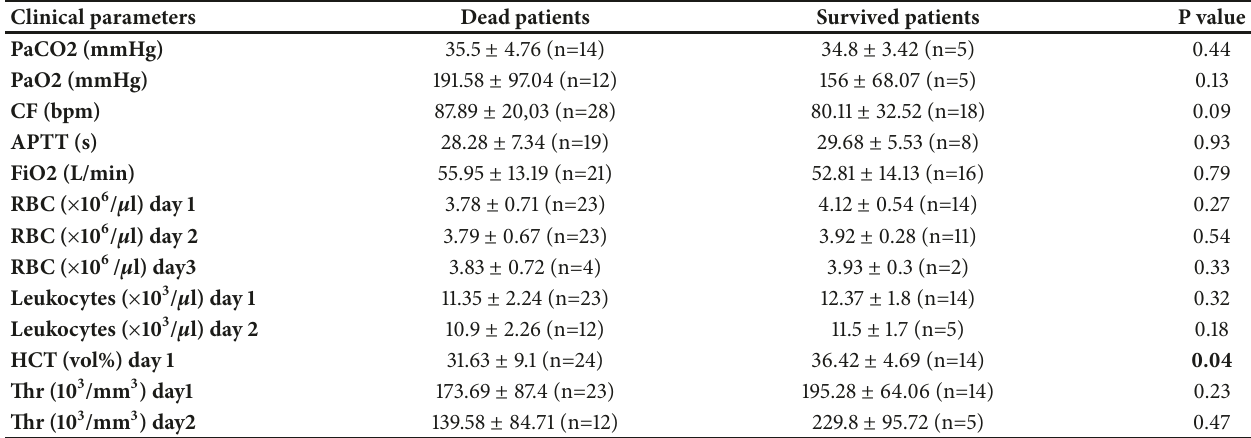
Table 2: Prognostic factors collected from medical record according to death and survival status.